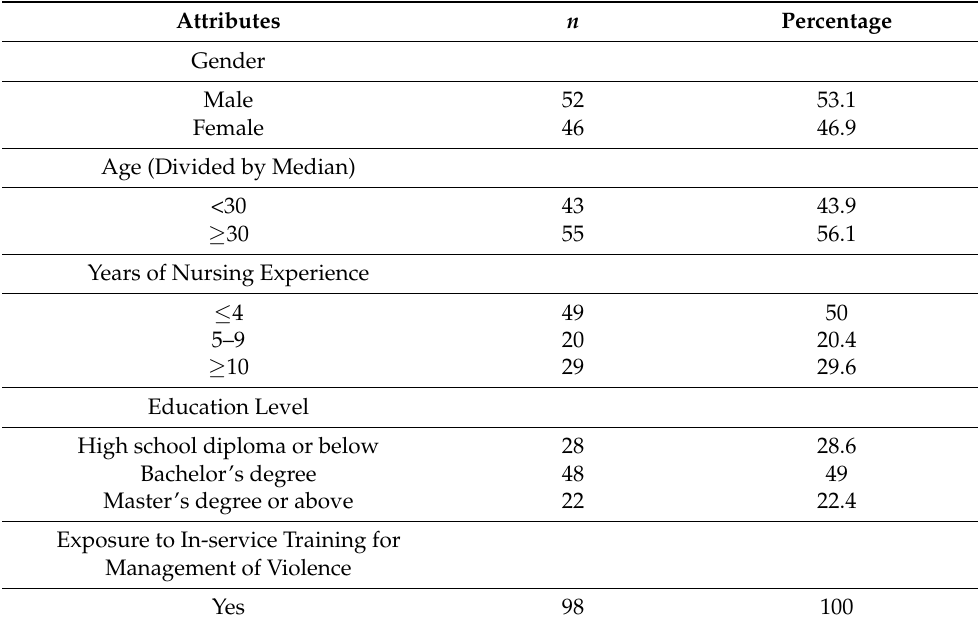
Table 1. Demographic characteristics of nurses ( n = 98).